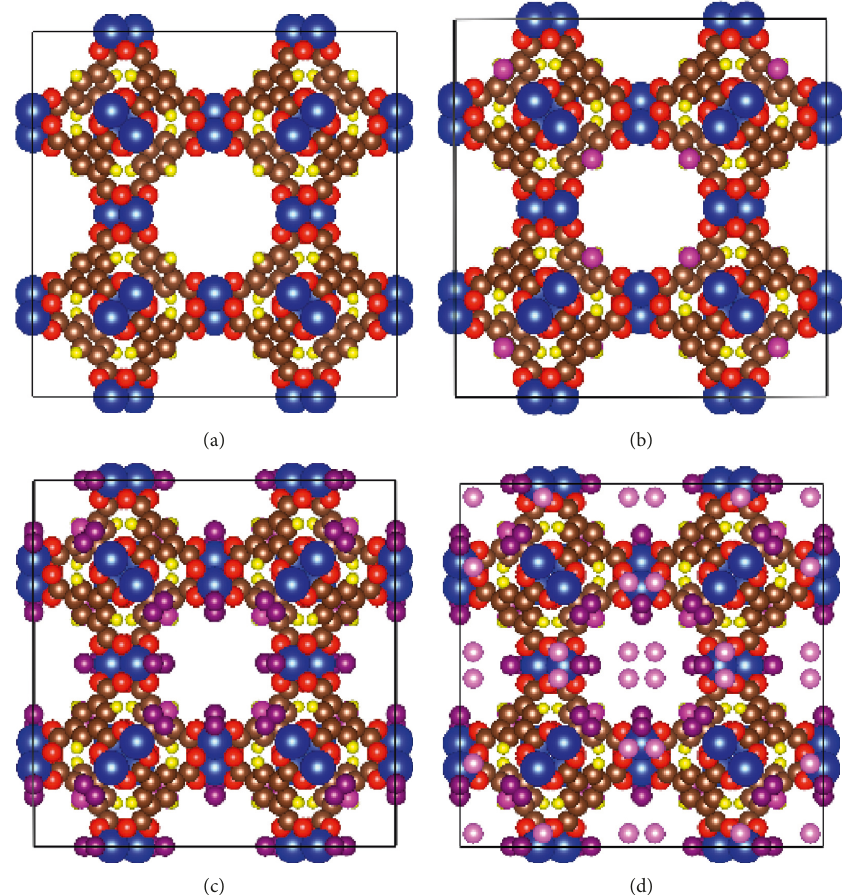
Figure 6: Schematics of the structure of (a) dehydrated CuBTC; (b) hydrated CuBTC with OW1; (c) hydrated CuBTC with OW1 and OW2; (c) hydrated CuBTC with OW1, OW2, and OW3. Symbols: Cu (blue), O (red), C (brown), H (yellow), OW1 (pink), OW2 (purple), and OW3 (light pink).